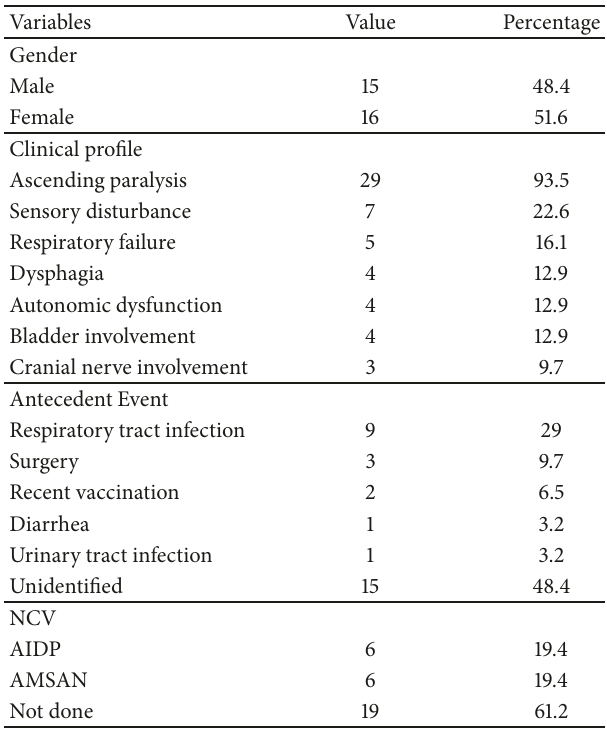
Table 2: Clinicoepidemiological study of Guillain-Barre